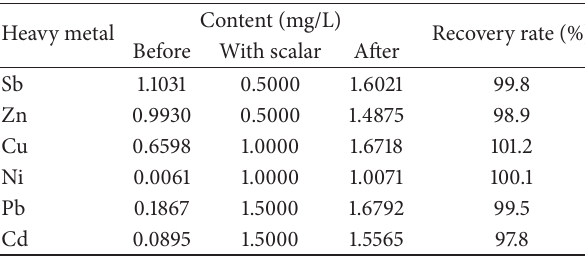
Table 1: The samples recovery rate of standard recovery